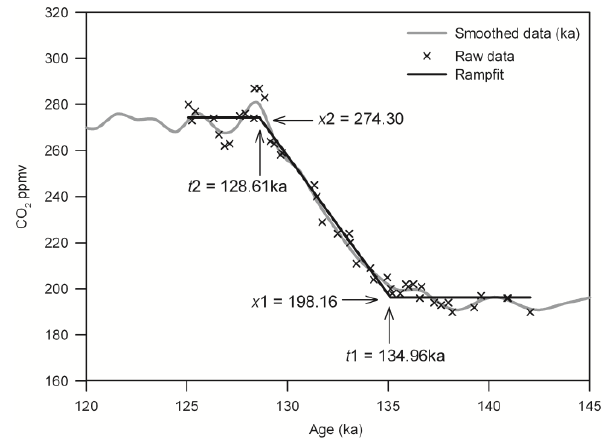
Fig. 3. Comparison of methods for determining peak glacial and in- terglacial values and termination amplitude, using EDC CO 2 . The glacial ( x 1 ) and interglacial ( x 2 ) values (in ppmv), and the begin- ning ( t 1 ) and end ( t 2 ) of the termination, are shown as calculated by